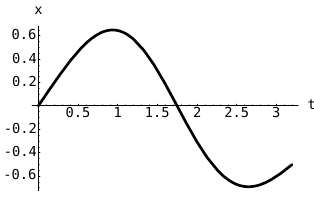
Figure 1. Solution of the prob- lem x ′′ + (1 + 3 t ) x = 0 , x (0) = 0 , x ′ (0) = 1 .